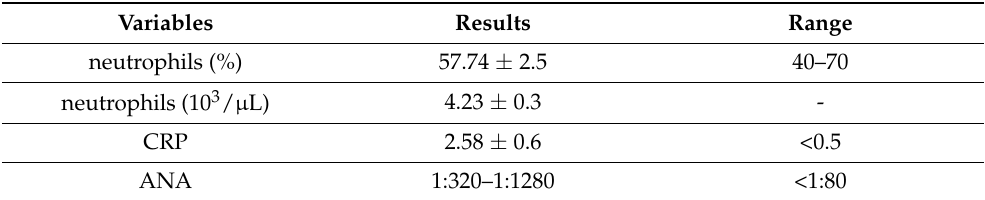
Table 2. Laboratory analysis of patients’ serum before starting the therapy. Variables